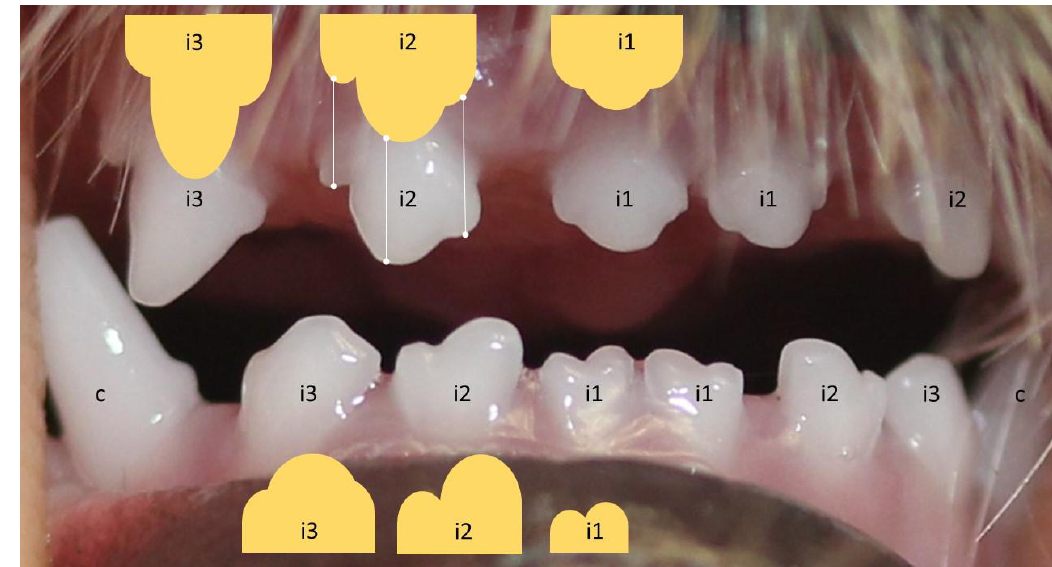
Figure 1. Special shaped incisors of a three-and-a-half-month-old Yorkshire Terrier. The two puppies developed their teeth at exactly the same rate. All images presented are from one of the dogs.